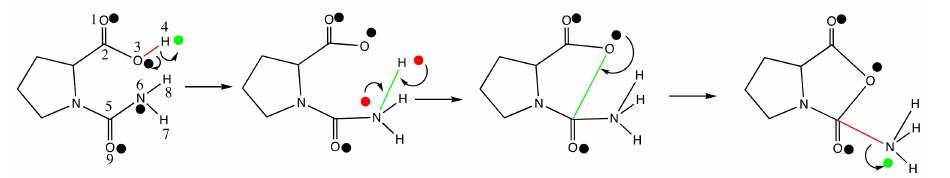
Scheme 10. Curly arrow representations of the main electron density flows of the reaction from 8 to 10